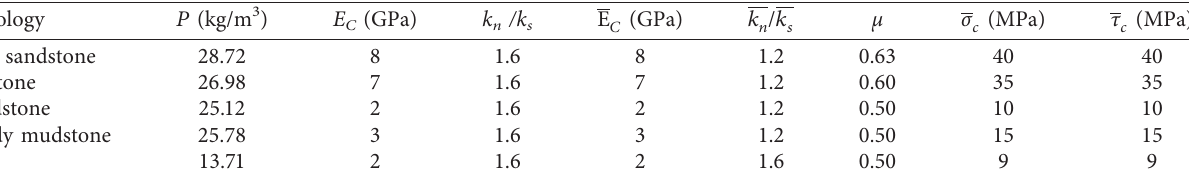
Table 1: Mechanical parameters of the coal and rock strata.